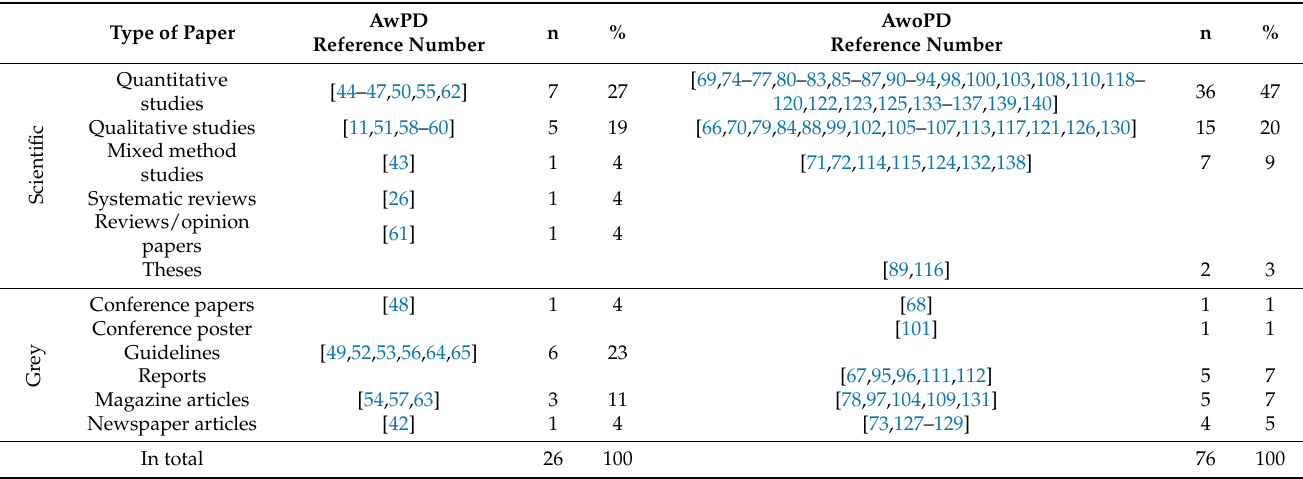
Table 2. Overview of the 102 included papers: 26 papers [11,26,42–65] on adults with physical disabilities (AwPD) and the remaining 76 papers [66–141] on adults without physical disabilities